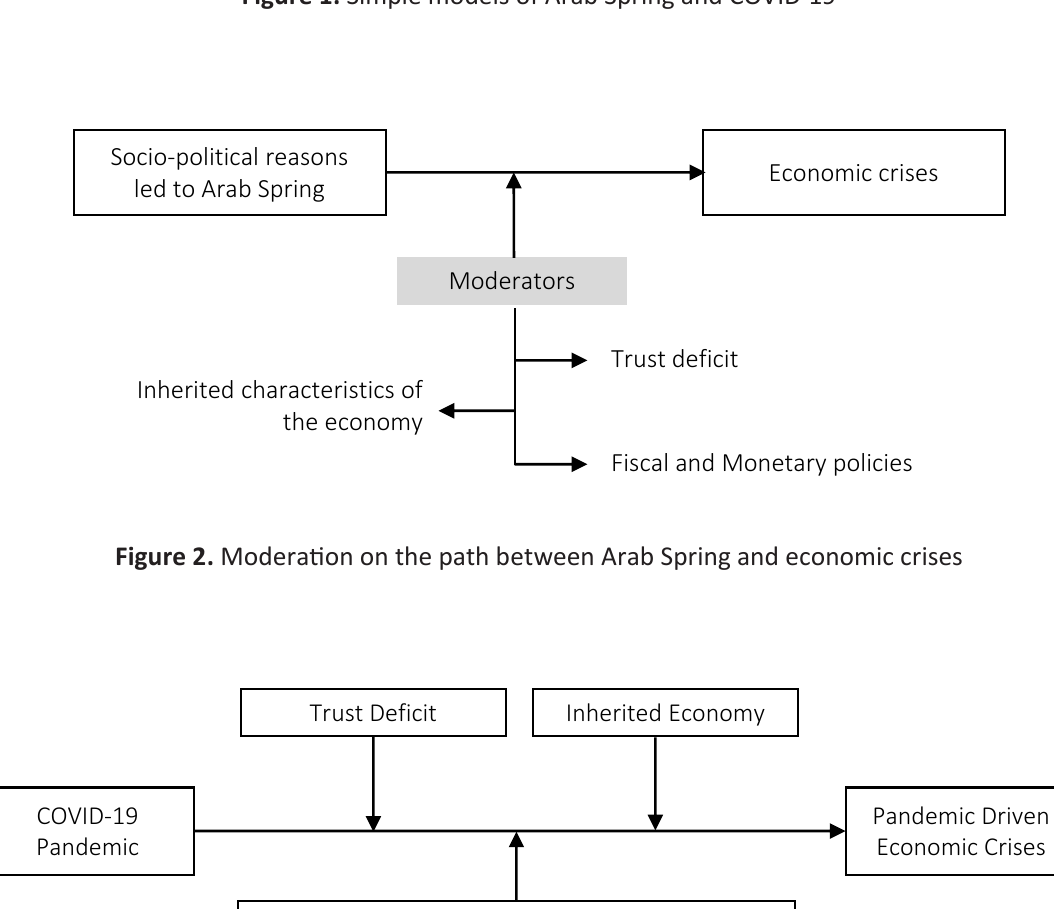
Figure 1. Simple models of Arab Spring and COVID-19